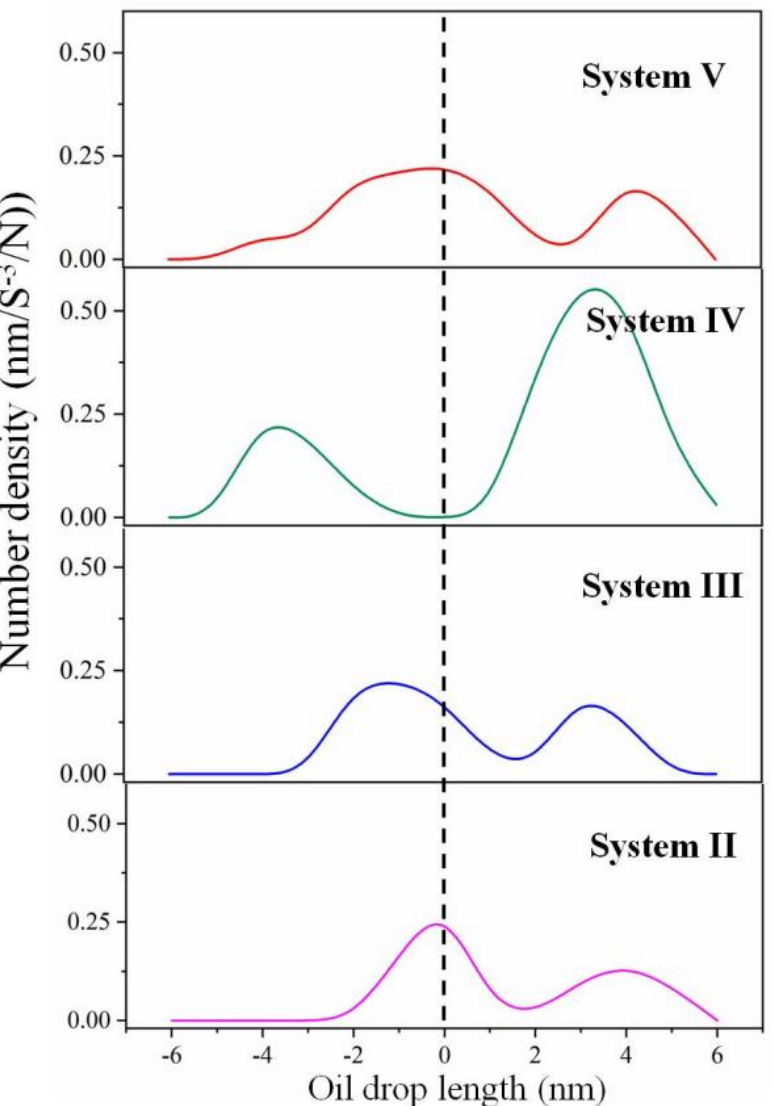
Figure 5. Density profile of SDS in oil droplets under electric field at the same time.